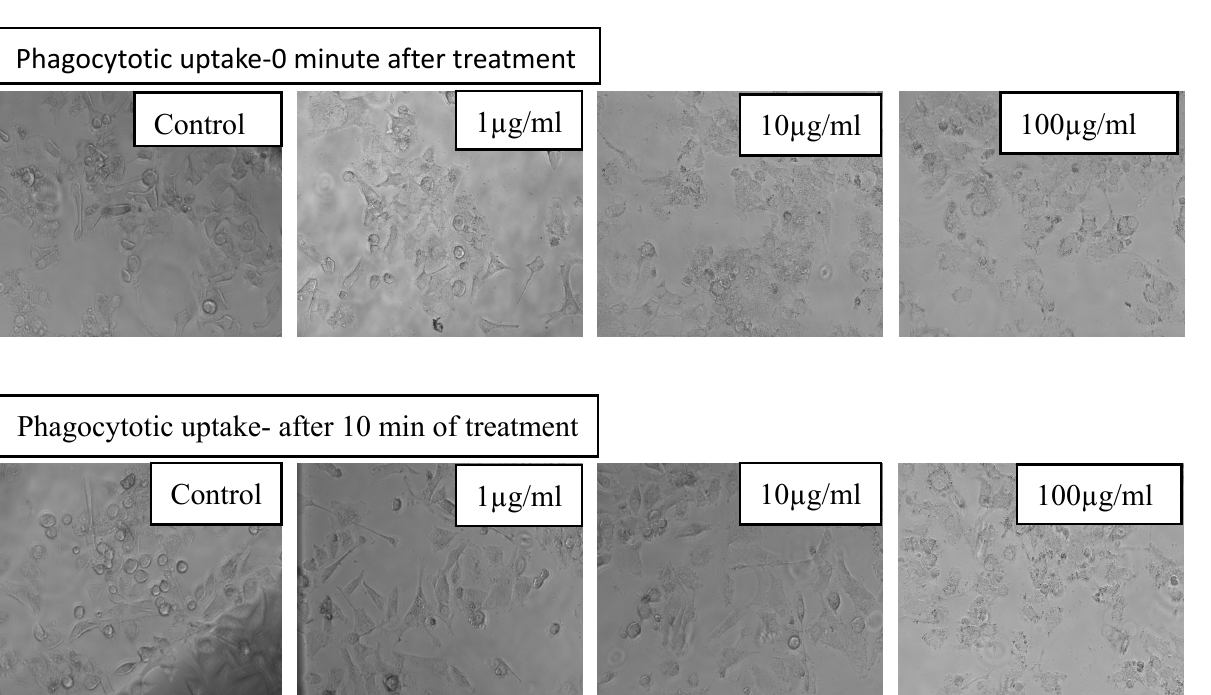
11 of 18 Figure 7. Scanning Electron Micrograph ( a ) SEM Micrograph ( b ) SEM micrograph at high magni- fication.